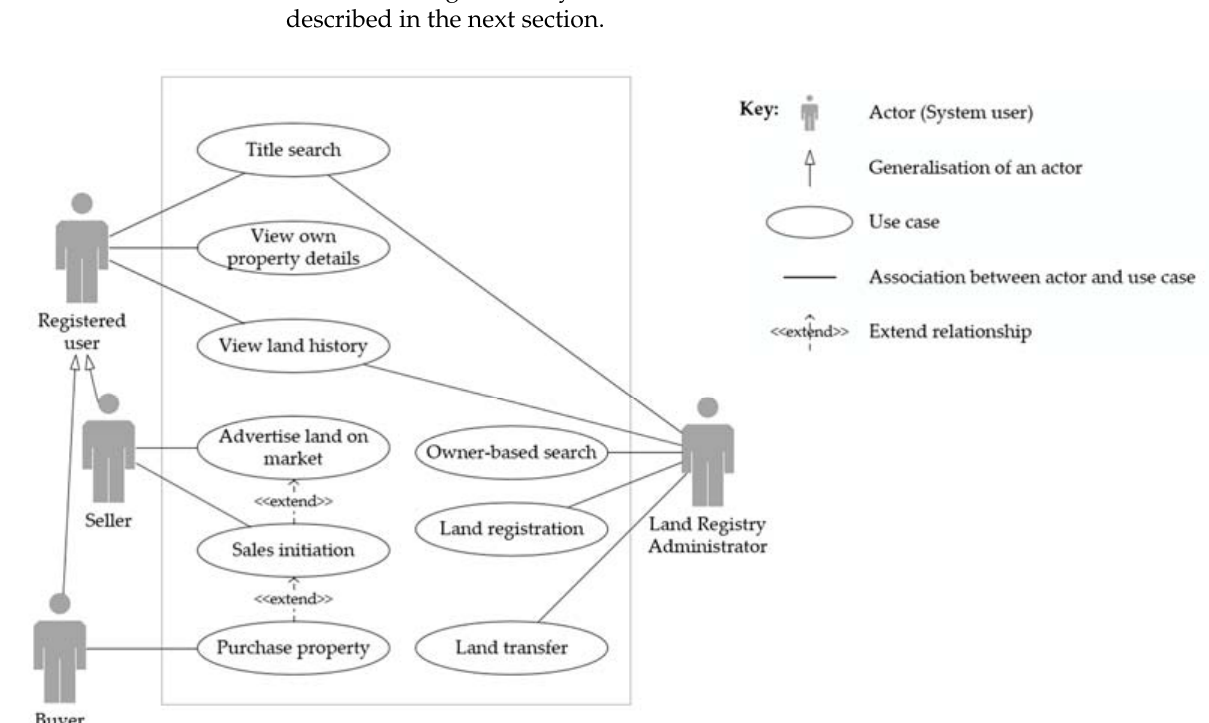
Figure 5. Use case diagram for property transactions.